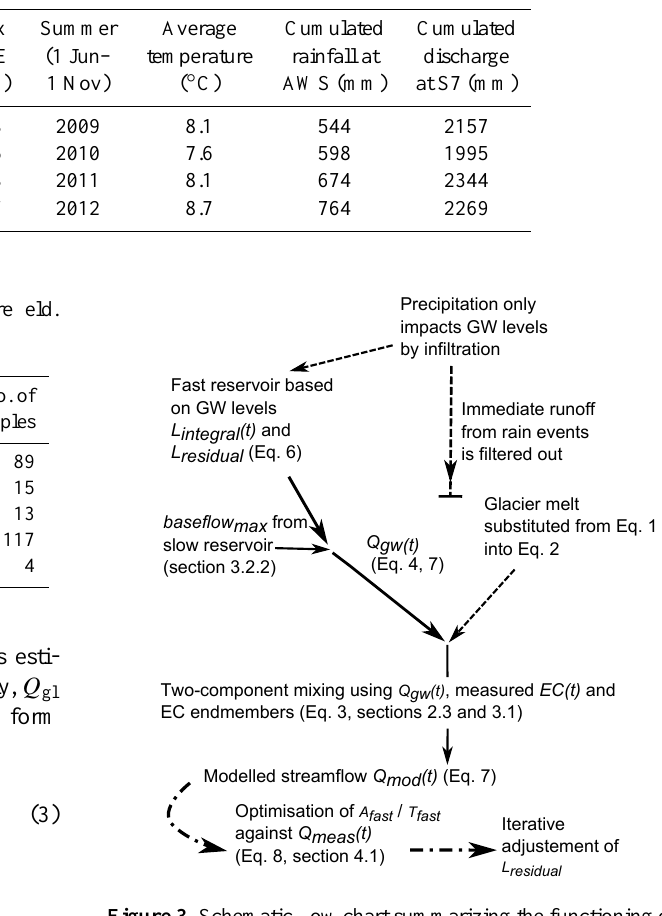
Table 1. Key hydrometeorological parameters of the catchment measured at the AWS and the main discharge station (S7, discharge only). Values in millimetres were calculated using a catchment area of 10.7km 2 . The start date for winter marks the establishment of a persistent snowpack at the AWS.